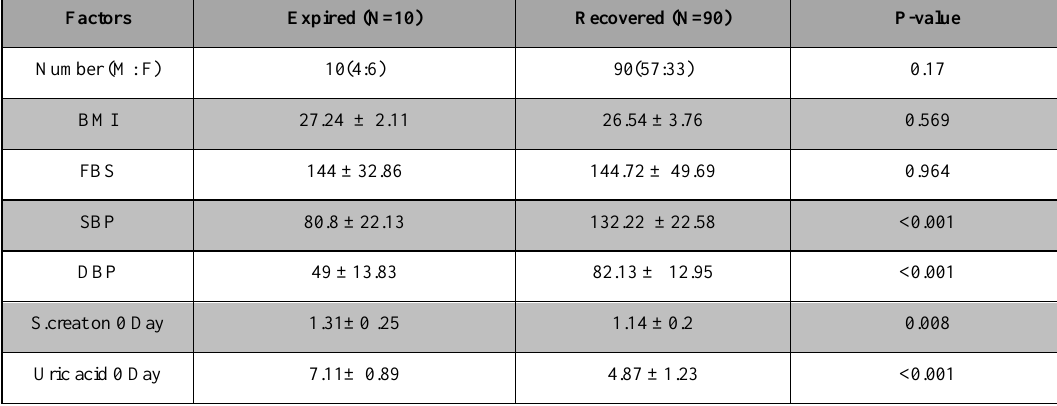
Table 3. Comparison of various parameters between those expired and survived cases.